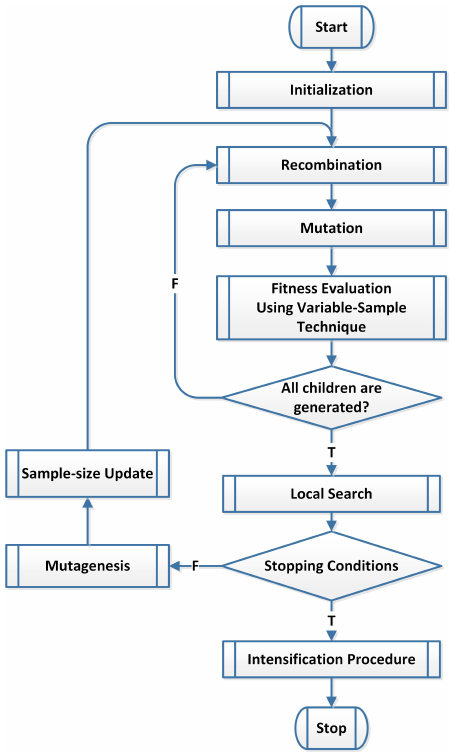
Figure 6. The structure of the DESSP